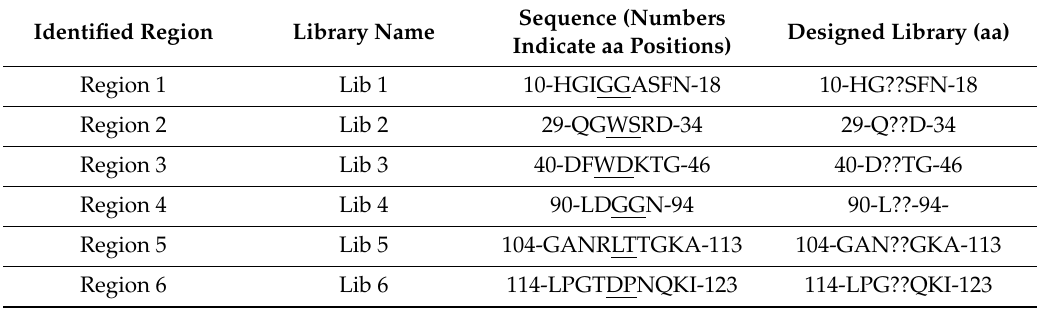
Table 1. Regions in BSLA structure identified through structural alignment and targeted for deletion / randomization. For each region, deleted amino acids are underlined, and randomized pairs are in bold and represented as question marks when